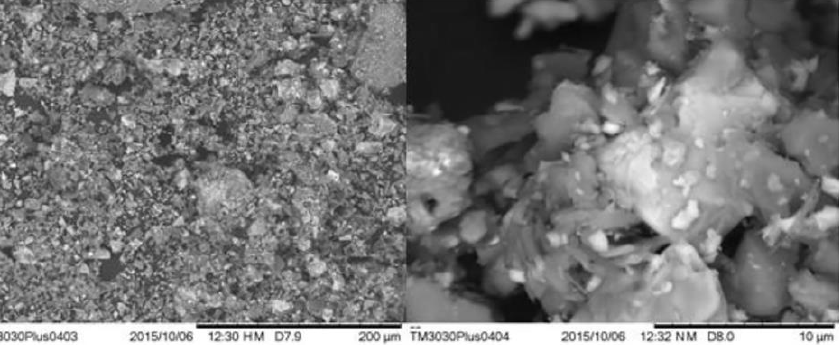
Figure 4. Microstructure of the mine tailing obtained through SEM by Coelho (2016) [27]. Table 1. Chemical composition of the mine tailing obtained by XRF.